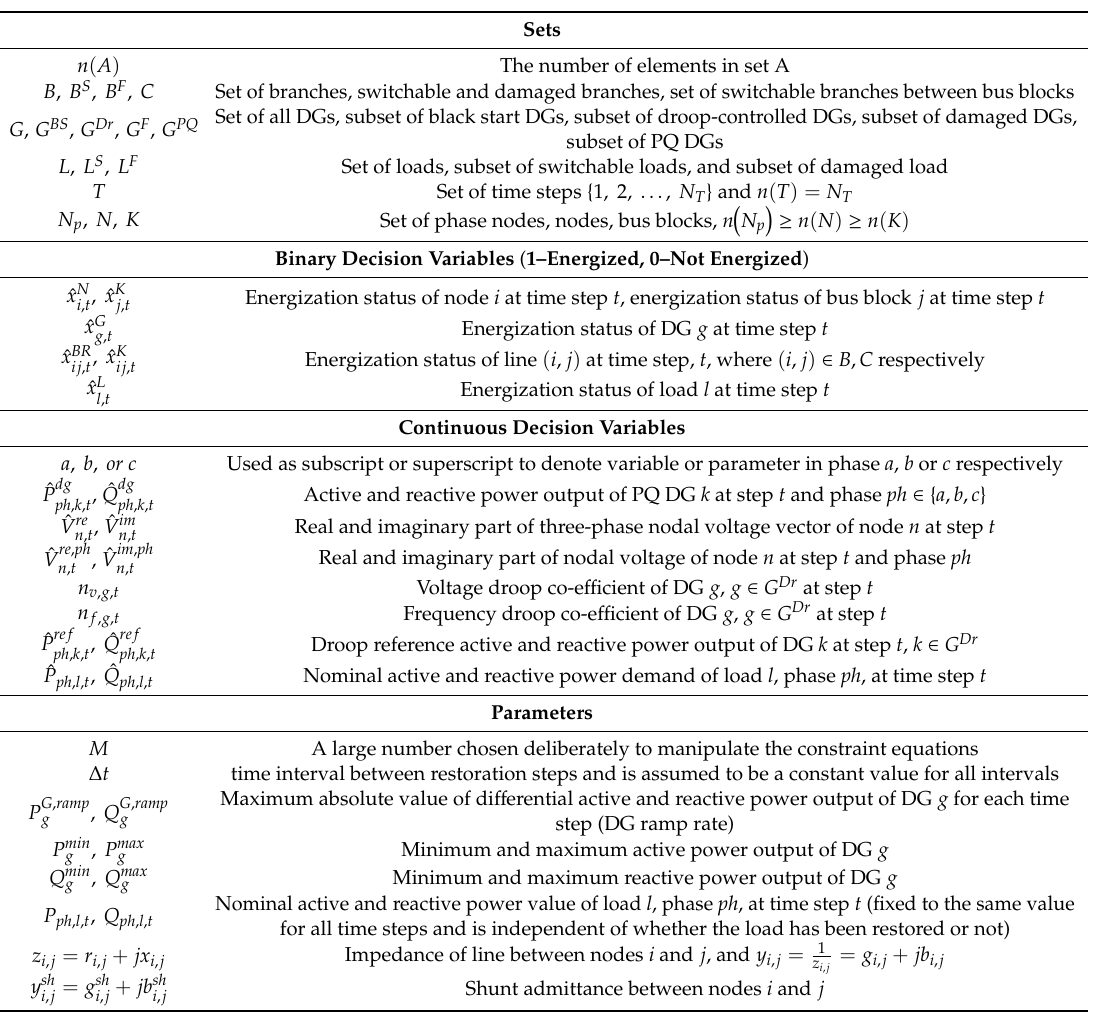
Figure 7. Flowchart of the proposed restoration method. Table 1. Symbols and parameters of the proposed restoration method.